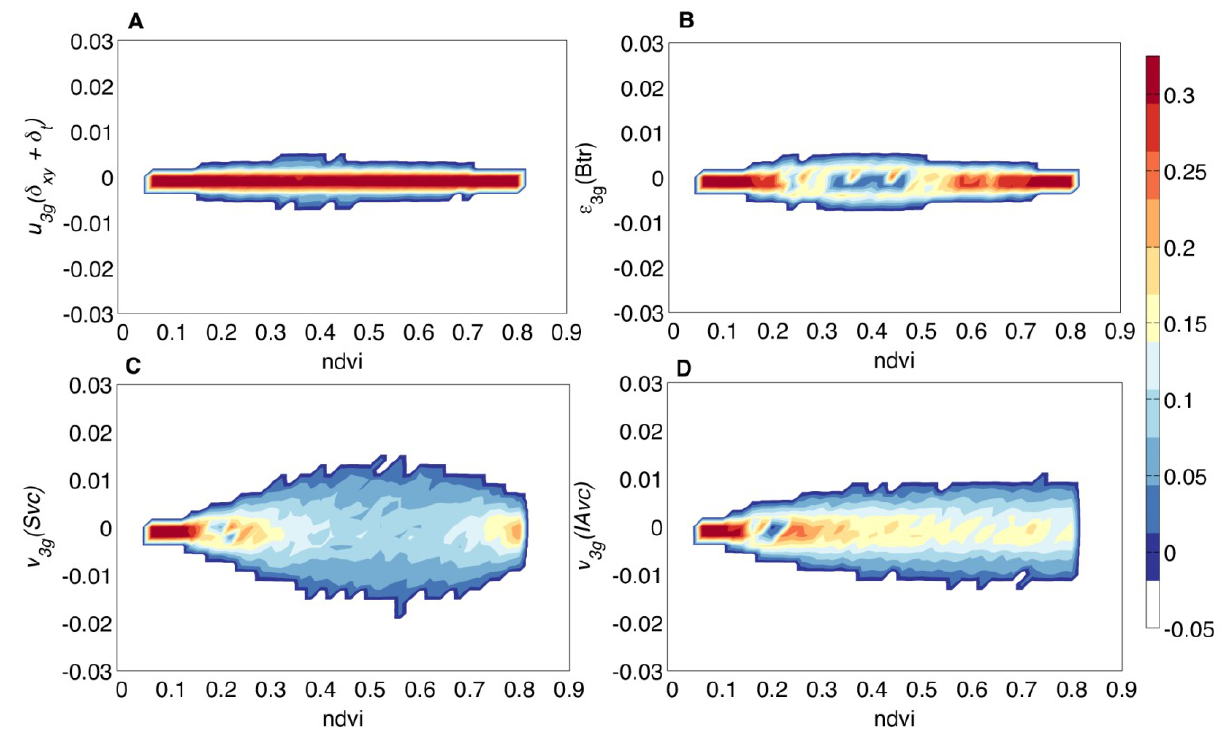
Figure 6. All panels show, at each NDVI value within the effective NDVI range, the distribution (vertical segments) for deviations from the mean of ( A ) the combined spatial and temporal coherent components (δ ( C ) the climate seasonal (Svc); and ( D ) inter-annual (IAvc) variability components. The color bar represents the mass or variable density concentration along the vertical